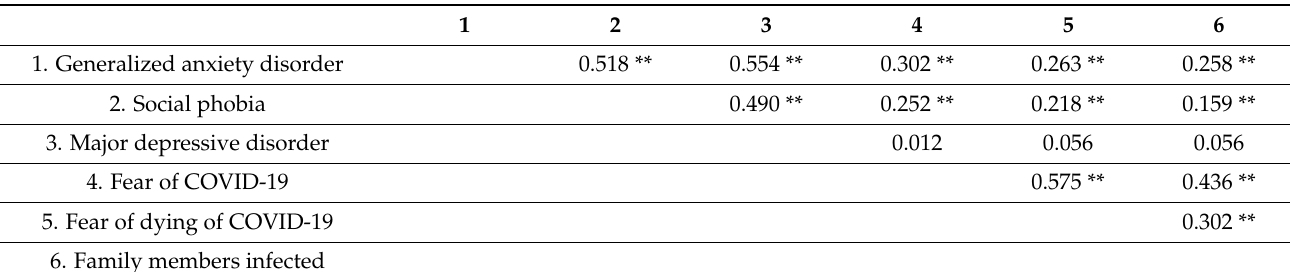
Table 2. Preliminary analyses.